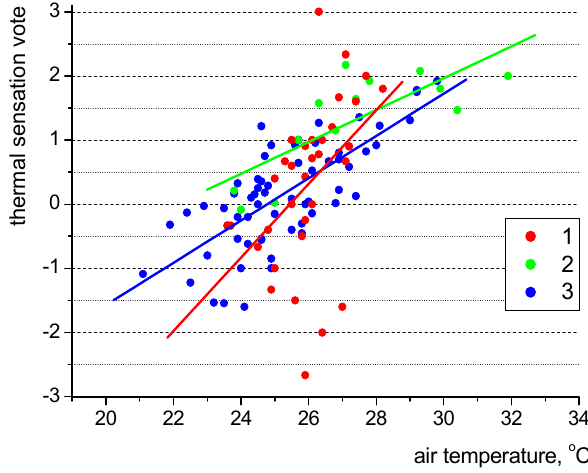
Figure 9. Thermal sensation vote vs. indoor air temperature in the Courthouse (1), “A” building (2) and “Energies” (3) with the best fit linear approximations (the red line is for the Courthouse, the green line for “A” building and the blue line for “Energis”),.